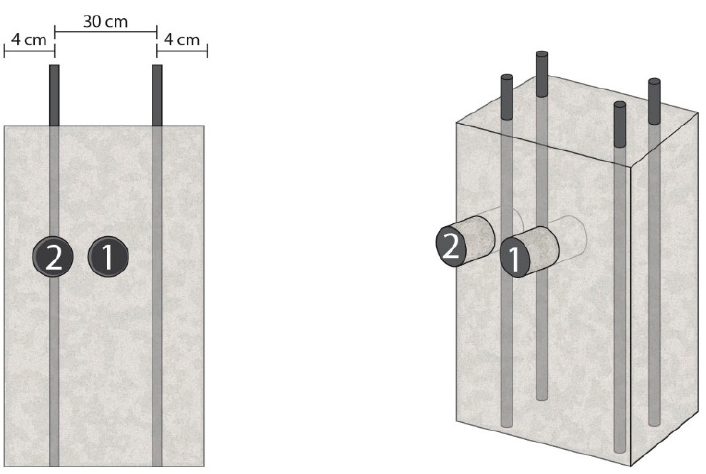
Figure 4. Extraction of two different core samples on prismatic reinforced concrete specimens. Point 1 is on the center of the biggest face of the specimen, and point 2 on the concrete cover, over the steel